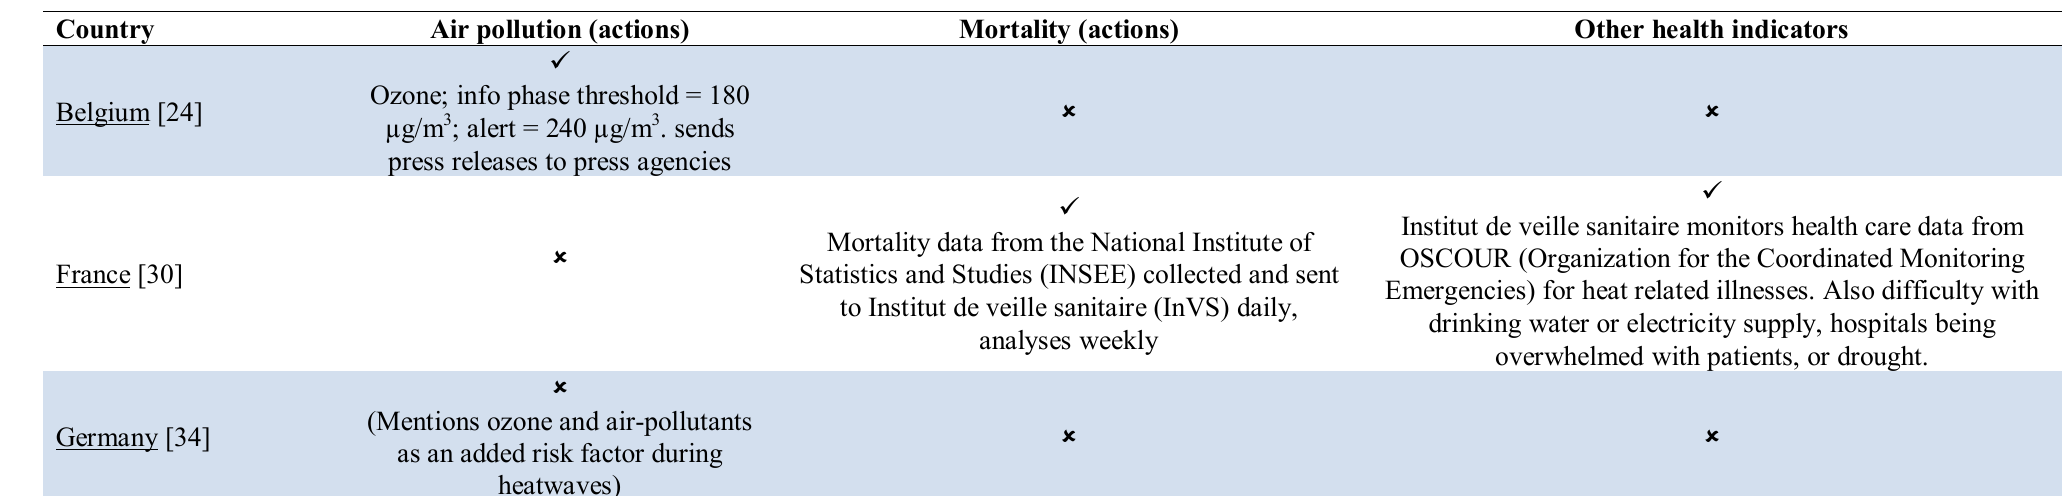
Table 2. Monitoring of other health indicators (air pollution, mortality,